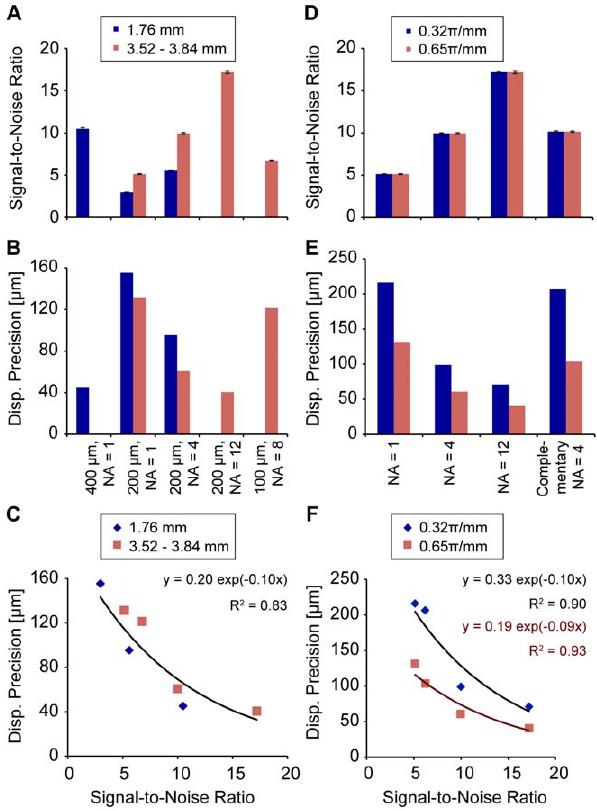
Figure 4. Effects of spatial resolution, slice thickness, gradient moment, and averaging. Displacement precision depends strongly on SNR of the displacement-encoded image. Finer in-plane spatial resolutions required increased NA or slice thickness (from 1.76 mm (dark blue) to 3.52–3.84 mm (light red)) to improve mean ( 6 standard deviation) SNR ( A ) and precision ( B ). Increasing the gradient moment from 0.23 p /mm (dark blue) to 0.65 p /mm (light red) has no effect on SNR ( D ) but improves precision ( E ). Complementary NA=4 acquisitions (phase advance=60 u , 180 u , 300 u ) did not significantly affect SNR and do not show improvements to precision compared to NA=4 scans (phase advance=180 u ). SNR and precision show an exponential relationship ( C , F ) that can inform the choice of imaging parameters for